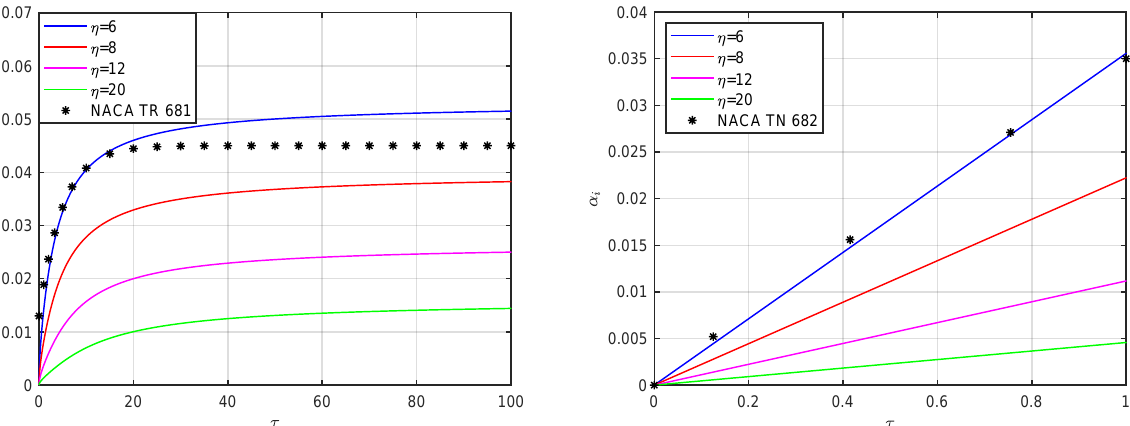
Figure 3. The approximate downwash gradient ( left ) and incipient angle ( right ) from a unit AOA step for thin elliptical wings in incompressible